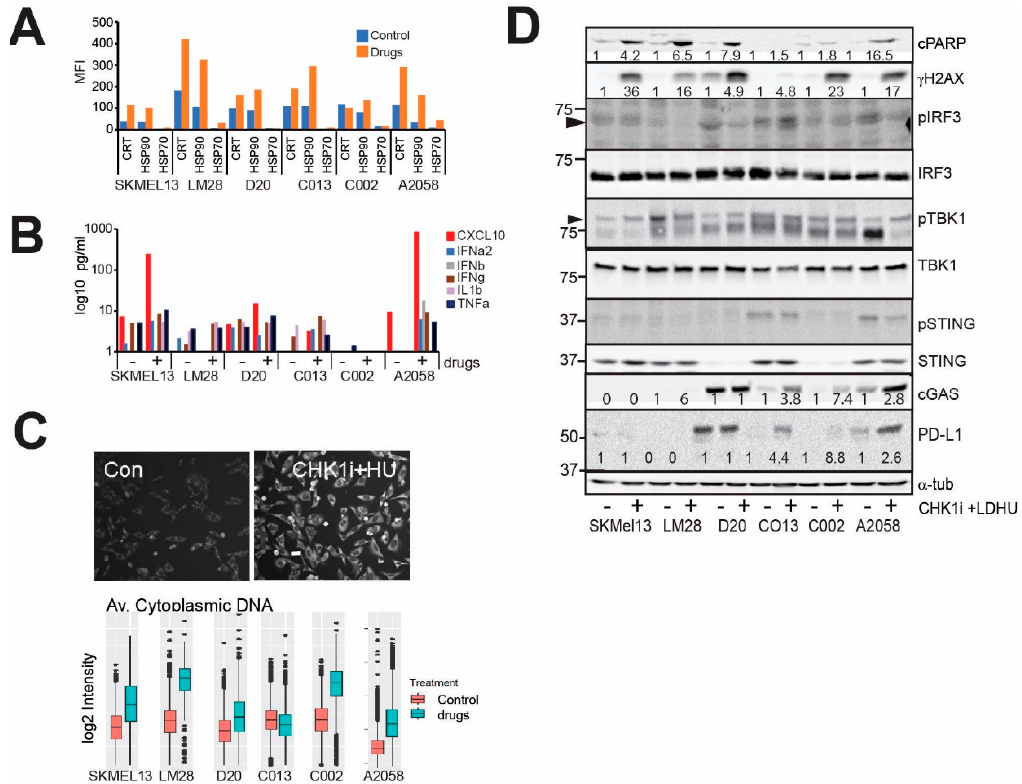
Figure 1. CHK1i+LDHU increases markers of ICD. ( A ). Human melanoma tumourspheres were treated with or without 0.2 μ M SRA737 + 0.1 mM HU and harvested at 48 h for analysis of the cell surface expression of calreticulin (CRT), HSP70 and HSP90 on live cells. These data are representative of two independent experiments. ( B ). The indicated human melanoma tumoursphere lines were treated with or without 0.1 μ M GDC-0575 + 0.1 mM HU for 48 h and the tissue culture supernatants were harvested and the cytokine levels measured. These data are representative of two independent experiments. ( C ). Immunostaining for cytoplasmic DNA in A2058 melanoma cells without and with treatment with 0.1 mM GDC-0575+0.1 mM HU (CHK1i+HU) for 48 h. Bar indicates 10 mm. The indicated melanoma cell lines were grown on plastic and treated as in B then fixed and stained for cytoplasmic DNA, and the level of staining was quantitated using high content imaging. The data are the mean and 95% CI from triplicate samples. ( D ). The indicated tumoursphere cultures were treated as in B and harvested at 24 h for immunoblotting of the indicated markers. The change in band intensity relative to the no-drug control for each cell line are shown. Where no changes are observed no quantitation is shown.